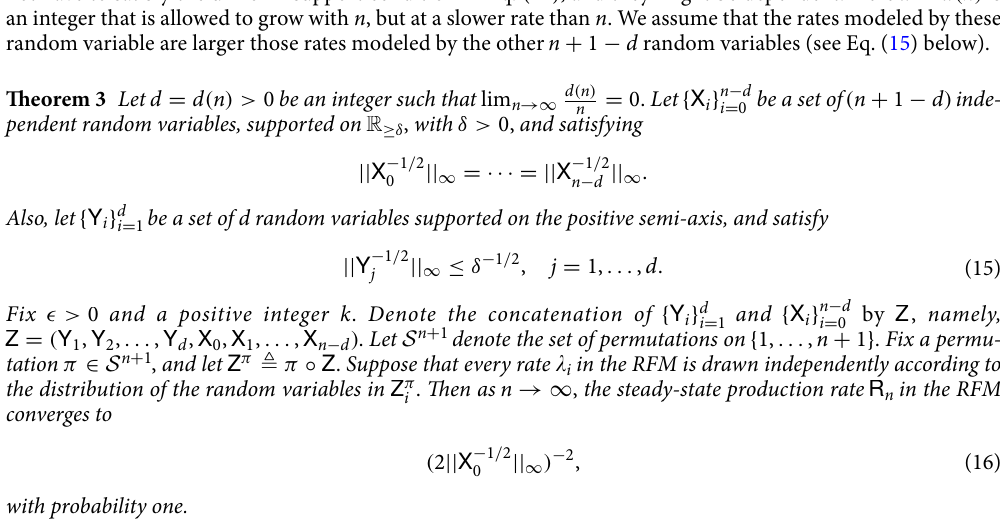
, R n converges to 1/2 with probability → ∞